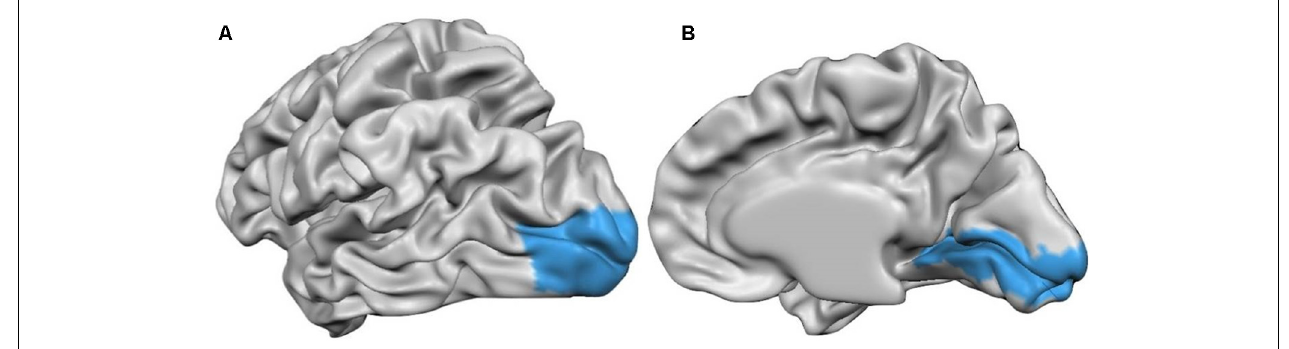
FIGURE 1 | Cortex surface view of the anatomically outlined BA17 used to measure the cortical thickness [ (A) left hemisphere (B) right hemisphere].